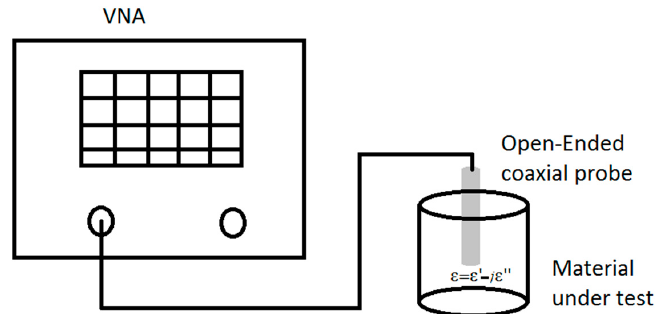
Figure 2. Setup of the open-ended coaxial probe technique for dielectric measurements in the solution of PVA/ZnO Nps.